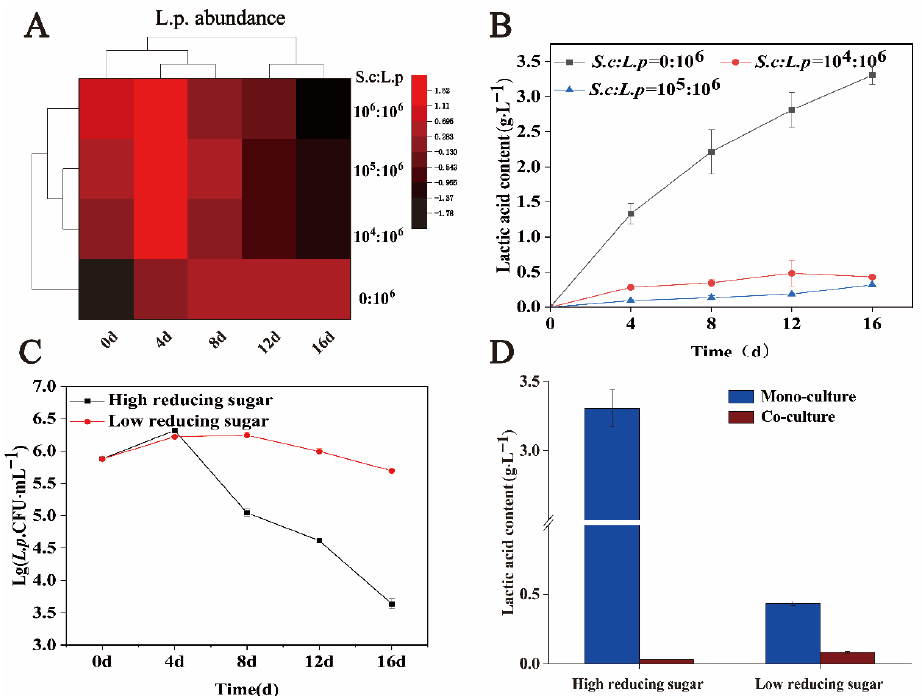
Figure 5. Effects of sugar concentration and the ratio of S. cerevisiae to L. panis in the simulated solid-state fermentation system on cell growth and lactic acid production of L. panis . ( A ) Influence of different inoculation ratios of S. cerevisiae to L. panis on cell growth of L. panis . ( B ) Influence of different inoculation ratios of S. cerevisiae to L. panis on lactic acid production of L. panis . ( C ) Cell growth of L. panis under monoculture conditions with different reducing sugar concentrations. ( D ) Lactic acid produced by L. panis under monoculture and co-culture conditions at different reducing sugar concentrations after 16 days of fermentation.